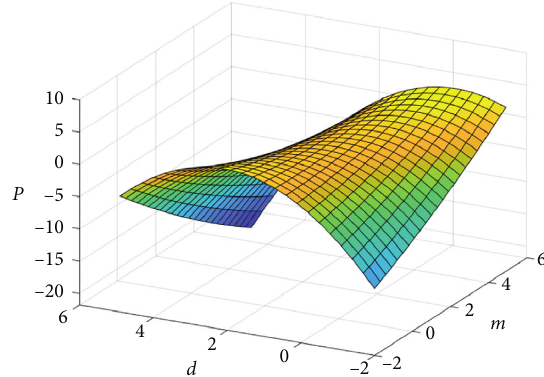
Figure 4: Relationship between self-leadership coefficient m and relational leadership coefficient d and leadership effectiveness P